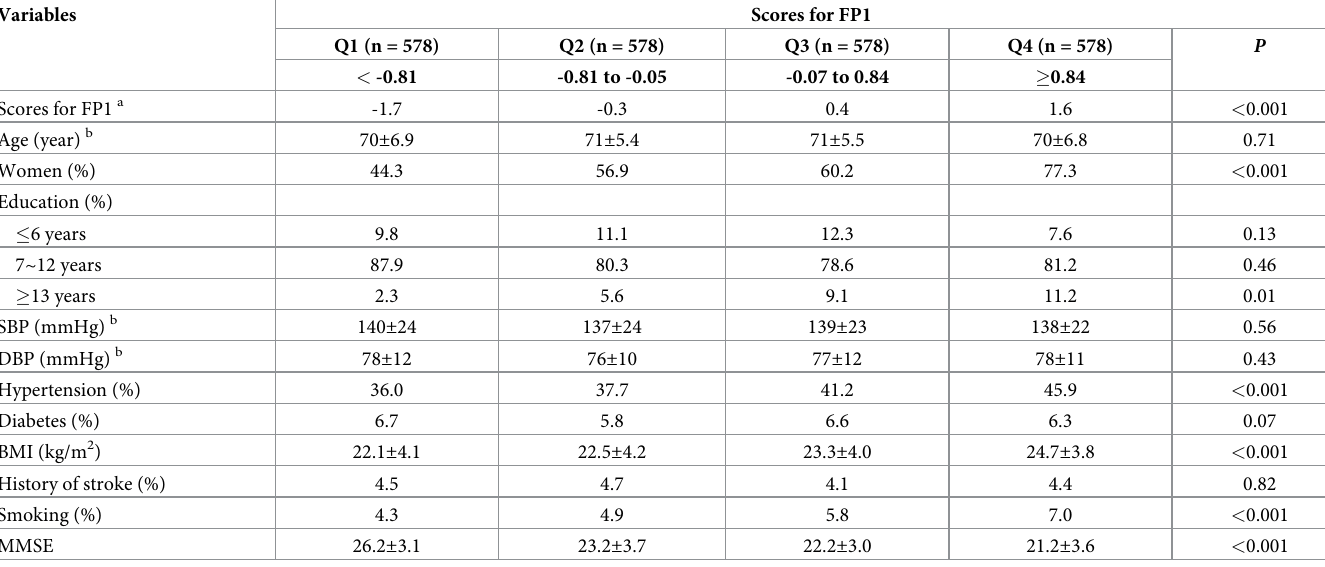
General linear model and Logistic regression analysis were used to test in mean values of risk factors across scores for the dietary pattern and in frequencies of risk factors across scores for the food pattern, individually. a All values are medians. b